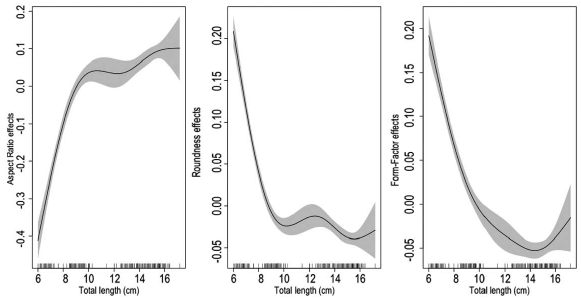
Fig . 4. – GAM modelling for the aspect ratio, roundness and form- factor as a nonlinear function of total body length of Strangomera bentincki off central-southern